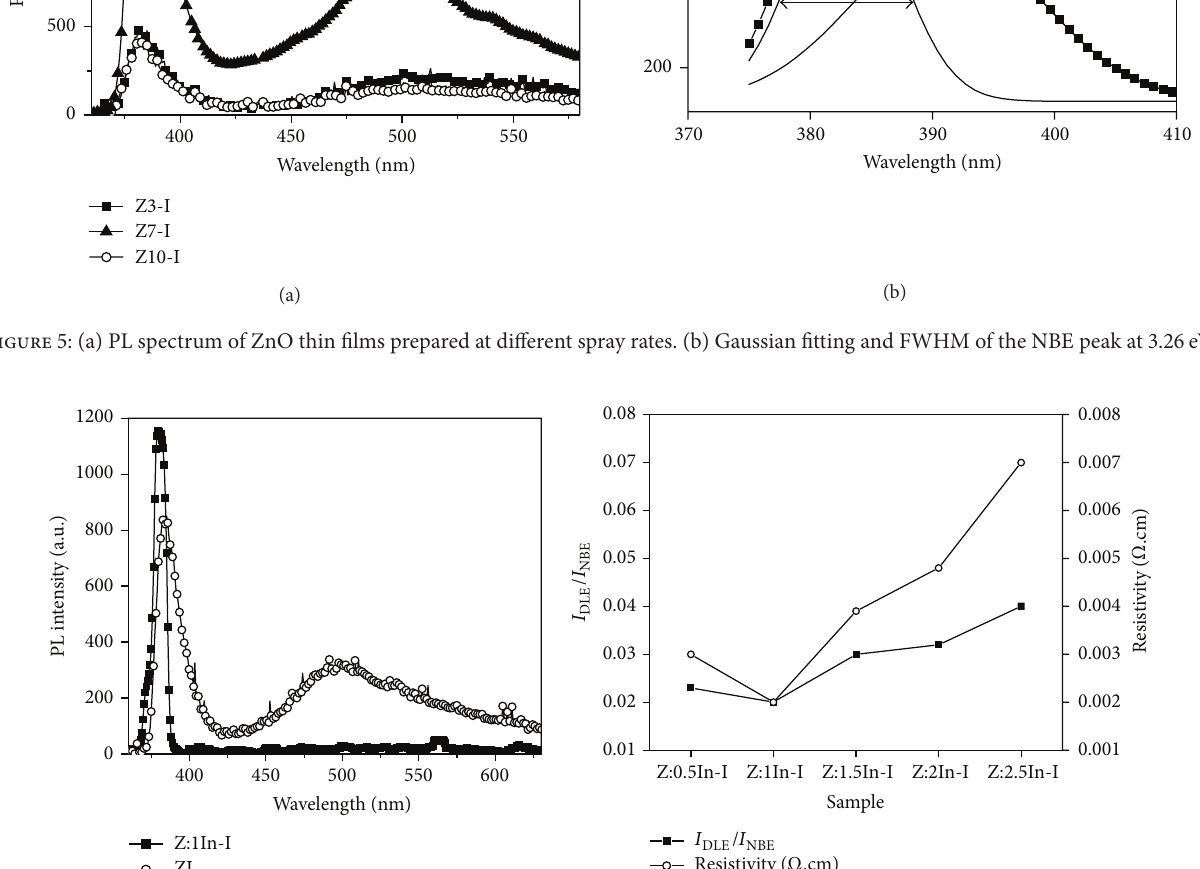
Figure 6: (a) Effect of indium doping on ZnO thin films. (b) Variation of 𝐼